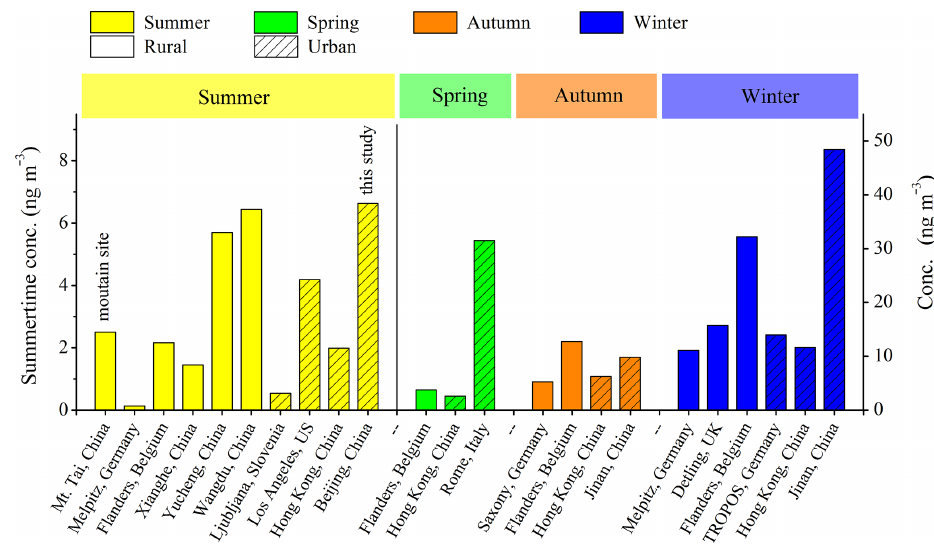
Figure 2. Summary of NAC concentrations across this and prior studies (see Table S2 for the data and references therein). The NAC concentrations in summer correspond to the left axis and other seasons correspond to the right